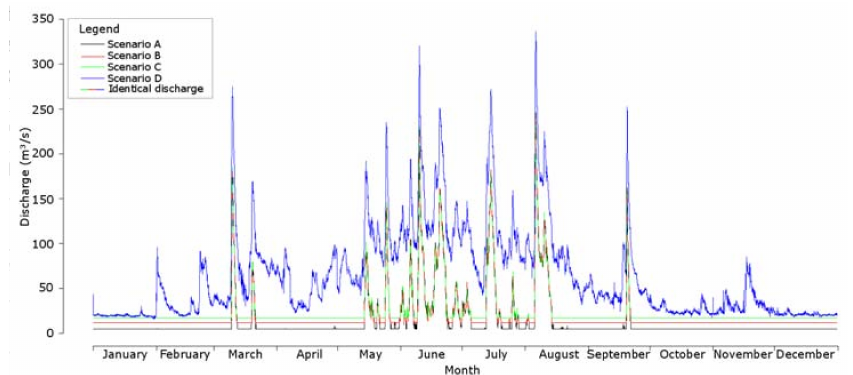
Figure 3. Hydrograph of the four scenarios based on data of the hydrological year